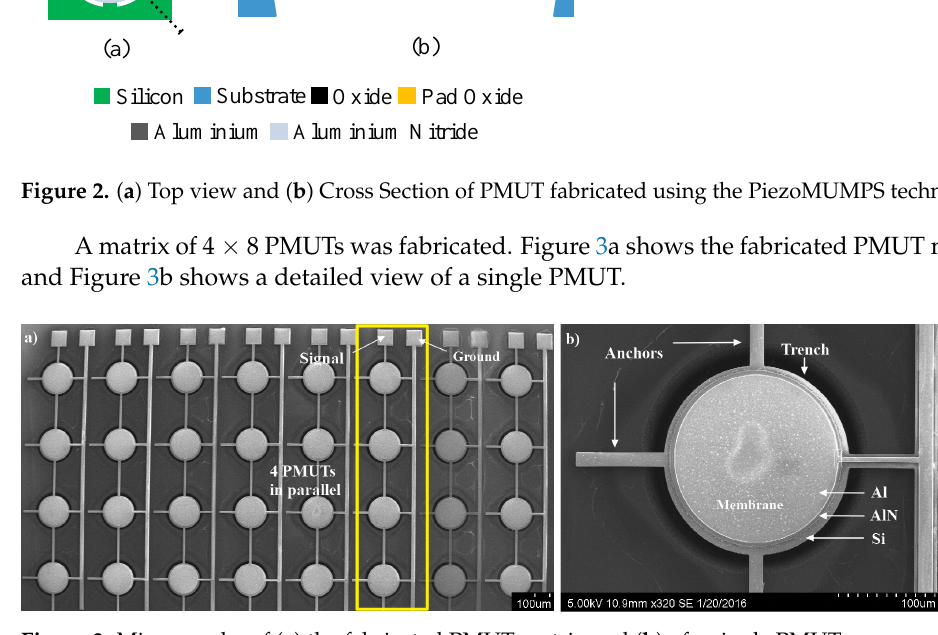
Figure 3. Micrographe of ( a ) the fabricated PMUT matrix and ( b ) of a single PMUT.